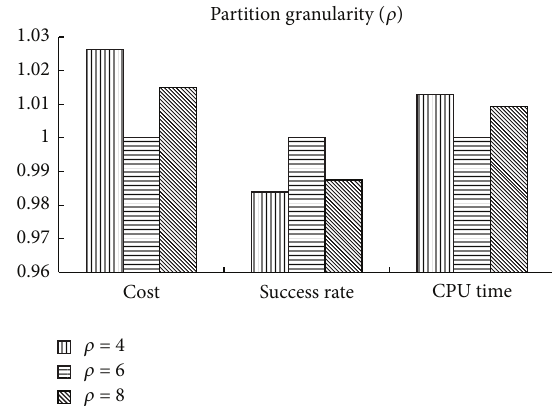
Figure 6: Comparison with different partition granularities (in percentage relative to 𝜌 = 6 ).